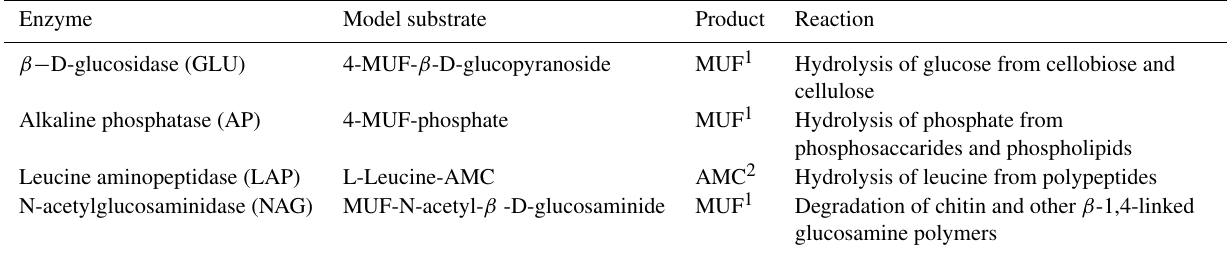
cellulose phosphosaccarides and phospholipids glucosamine